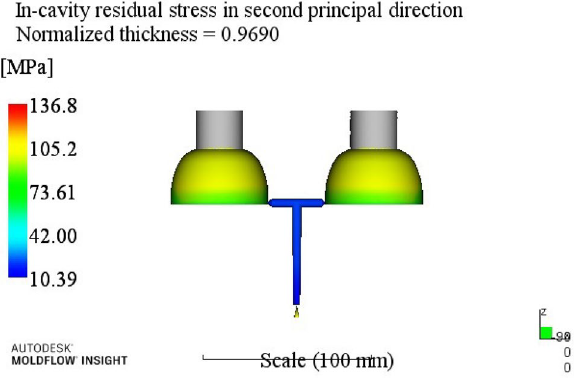
Figure 7. The second direction residual stress optimization